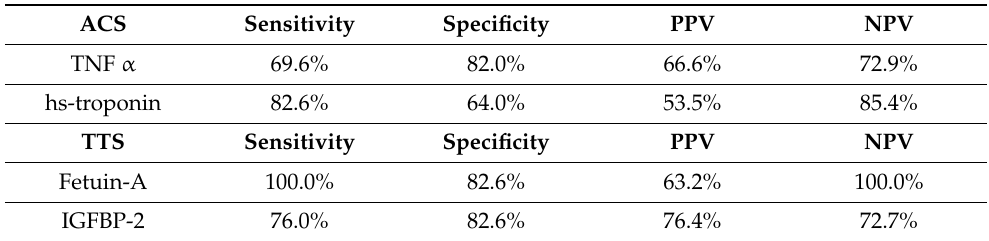
Figure 2. ROC curves and cut-off scores for IGFBP-2 (IGFBP), TNF α (TNF alpha), Galectin-3 (Galectin), Fetuin-A (fetuina), and high sensitive troponin (hstroponin) for prediction of ACS in the total cohort (including patients with ACS and TTS).